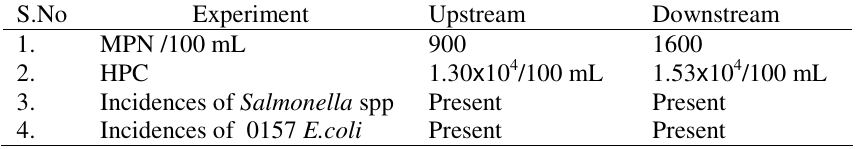
Table 7. Microbiological analysis of upstream and downstream